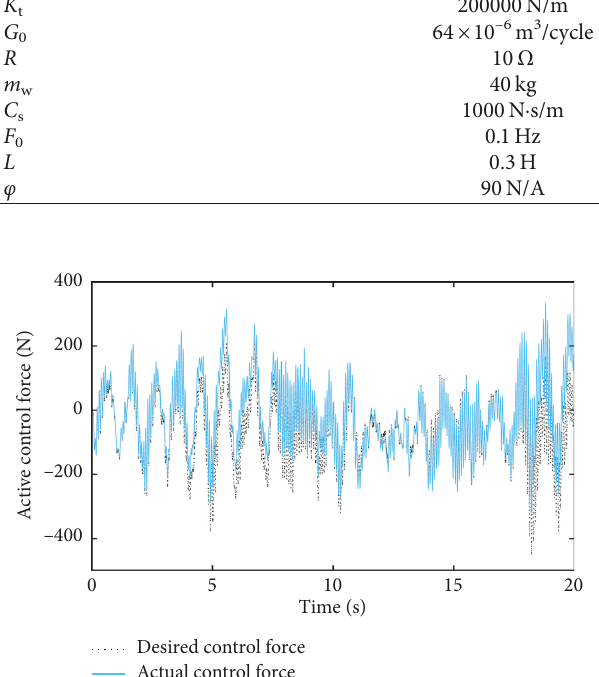
Figure 7: Active control force.